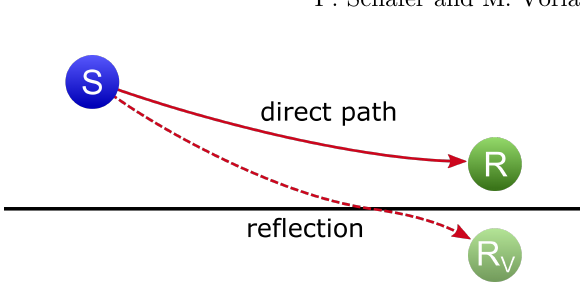
Figure 4. Virtual receiver position considered to fi nd eigenray of ground re fl